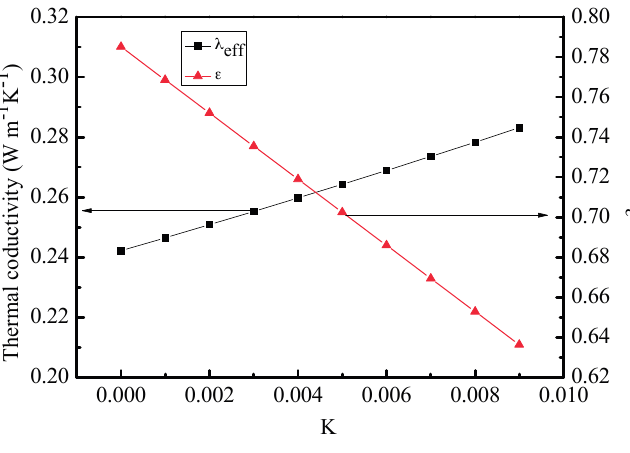
Figure 9. Varying porosity and thermal conductivity at different